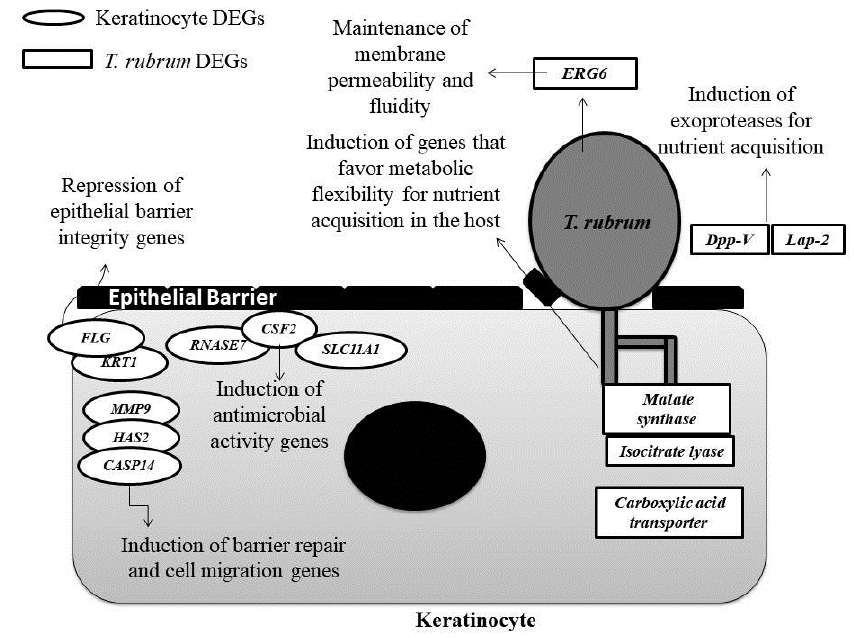
Figure 4. The schematic overview of the T. rubrum -keratinocyte interaction. The genes differentially expressed (DEGs) during host-pathogen interaction discussed in this paper are shown.